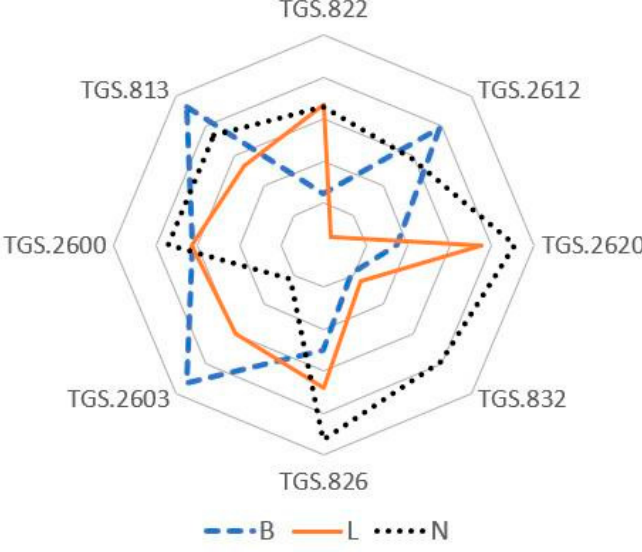
Figure 4. Radar plot of the average sensor responses obtained with the gas sensor array for each bacterial sample. N: TSB uninoculated; L: TSB inoculated with L. monocytogenes , B: TSB inoculated with B. cereus .